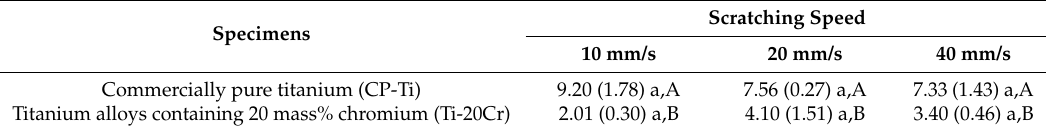
Figure 7. Microscope image (100× magnification) of the scratched areas in both commercially pure titanium (CP-Ti) and titanium alloys containing 20 mass% chromium (Ti-20Cr) at 10 mm/s scratching speed: ( a ) CP-Ti; ( b ) Ti-20Cr. Table 2. Mean (standard deviation) of the profile depth (Pt; μ m) in the scratched area of both commercially pure titanium (CP-Ti) and titanium alloys containing 20 mass% chromium (Ti-20Cr) at different scratching speeds. upper case letters in the same row indicate that the groups are significantly different ( p < 0.05).